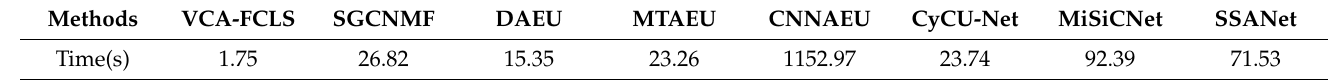
Table 12. Consumption time (in seconds) for all the unmixing